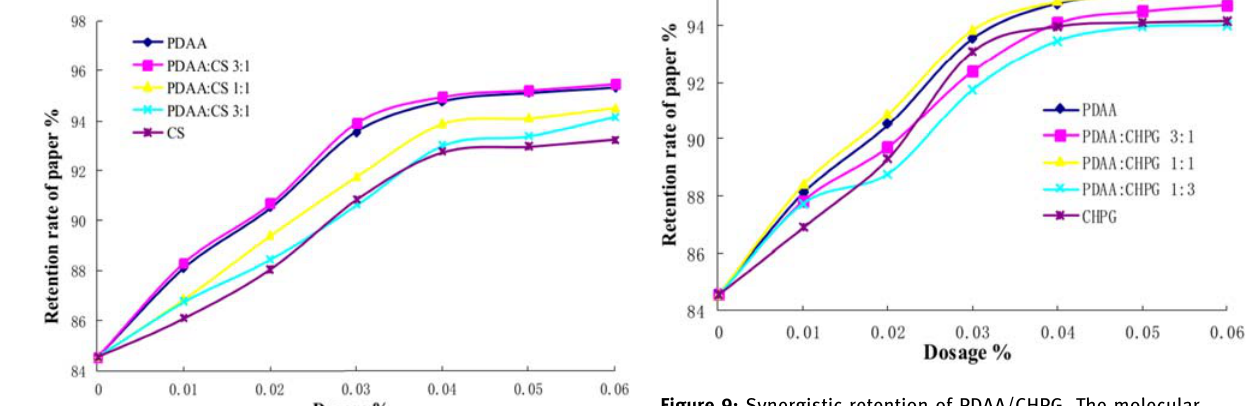
Figure 9: Synergistic retention of PDAA/CHPG. The molecular weight of PDAA is 4